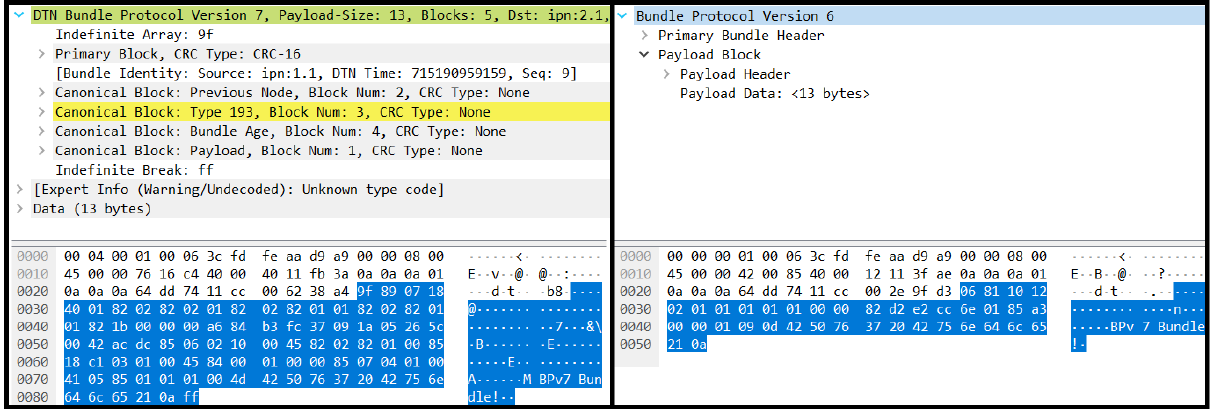
Figure 12. Translation of BPv7 to BPv6. The bundle layer bytes are highlighted in